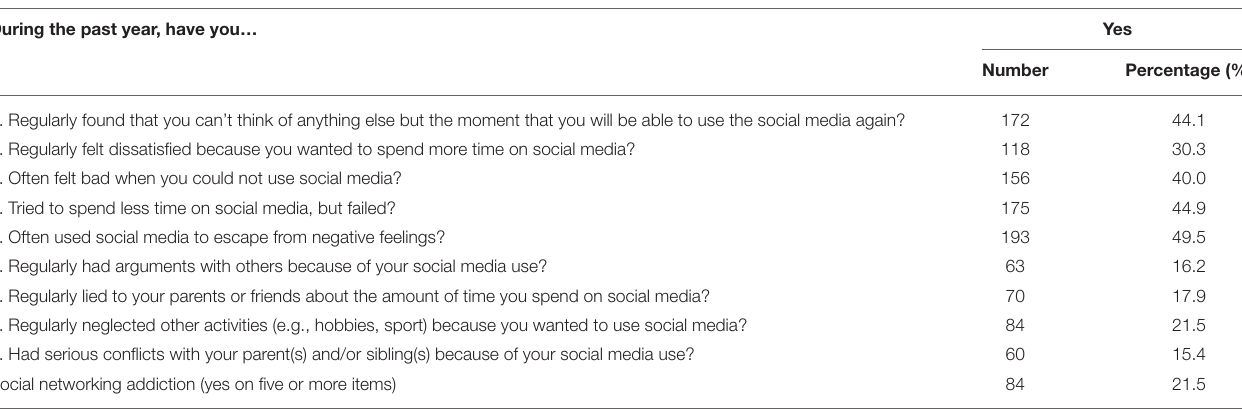
TABLE 3 | Prevalence of social networking addiction behaviors. During the past year, have